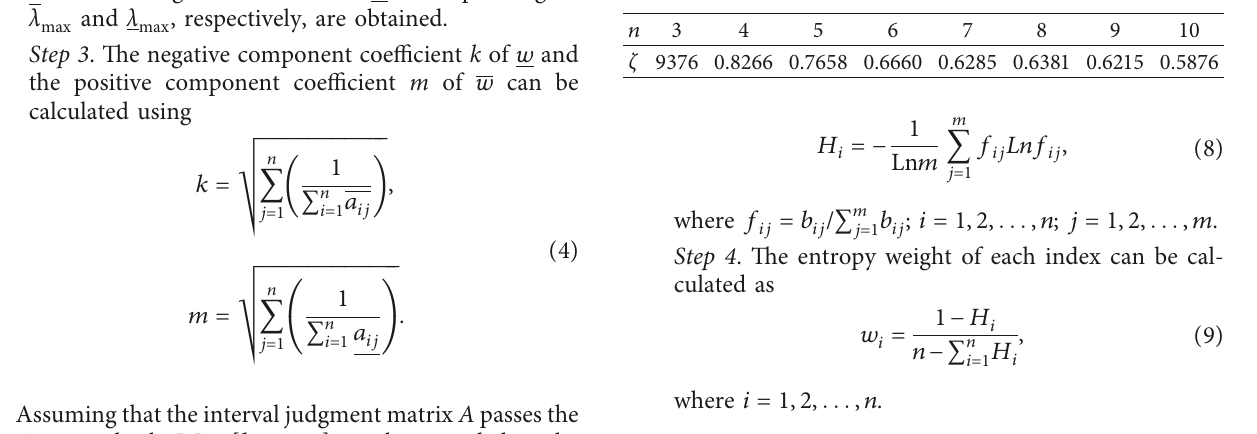
Table 2: Correlation coefficient